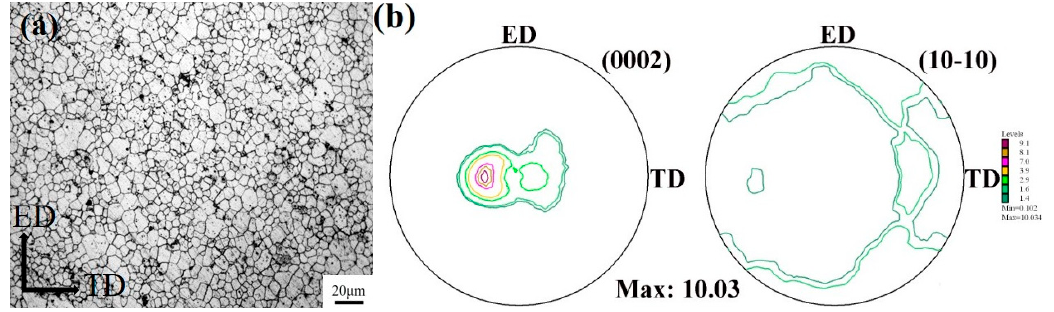
Figure 1. The microstructure (LM) and texture of AZ80 alloy: ( a ) As-extruded; ( b ) the (0002) and (10-10) pole figures.